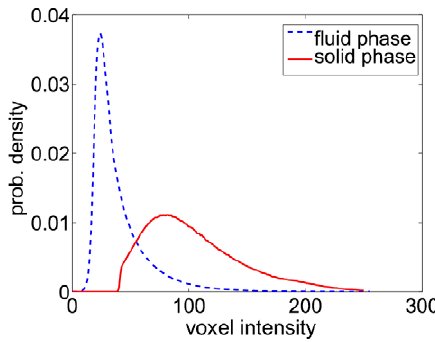
Figure 3. Voxel intensity distributions of the solid and the fluid phase. The two distributions show a wide overlap. No global threshold can be found, even in principle, for separating the two phases, without also producing some false positive and false negative voxels.